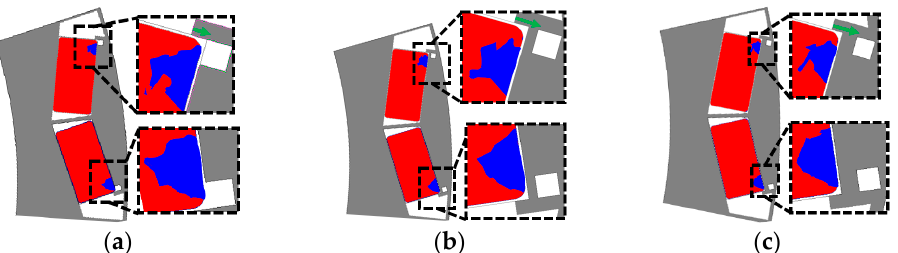
Figure 15. Irreversible demagnetization region with different air hole positions towards an air gap: ( a ) 0 mm, ( b ) 0.4 mm, ( c ) 0.8